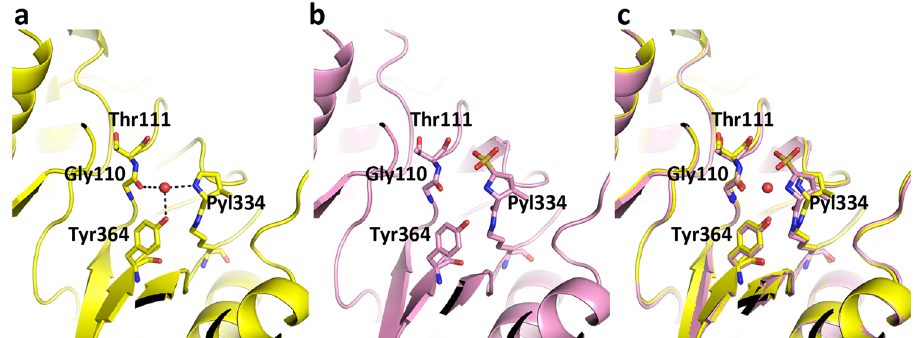
Fig. 2 Comparison of the active site in MttB and sul fi te-bound MttB. Ribbon diagram of the active site of ( a ) MttB (yellow) and ( b ) sul fi te-bound MttB (violet) and ( c ) their superposition. Gly110, Thr111, Pyl334, Tyr364, and the sul fi te bound to pyrrolysine are shown in stick with the non-carbon atoms colored in CPK. The water hydrogen bonded to Pyl334 in the MttB structure is shown as a red sphere. This water is absent in the sul fi te-bound MttB structure. Hydrogen bonds are shown as dashed